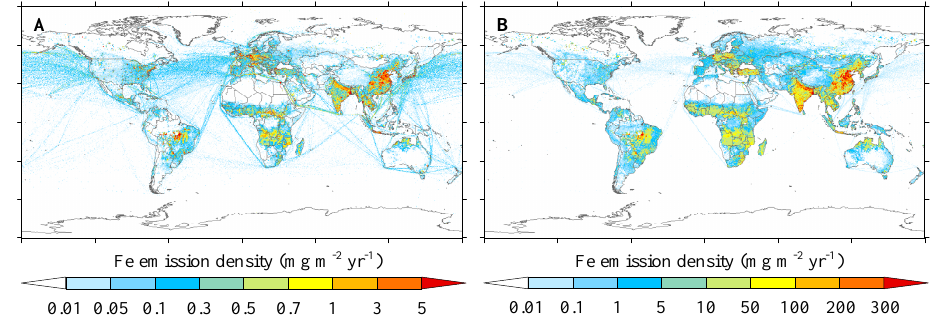
Figure 3 Figure 3. Spatial distributions of Fe emissions from combustion sources in 2007 at a resolution of 0.1 ◦ × 0.1 ◦ for fine (PM medium-to-coarse (PM 1 − 10 and PM > 10 ) (b)